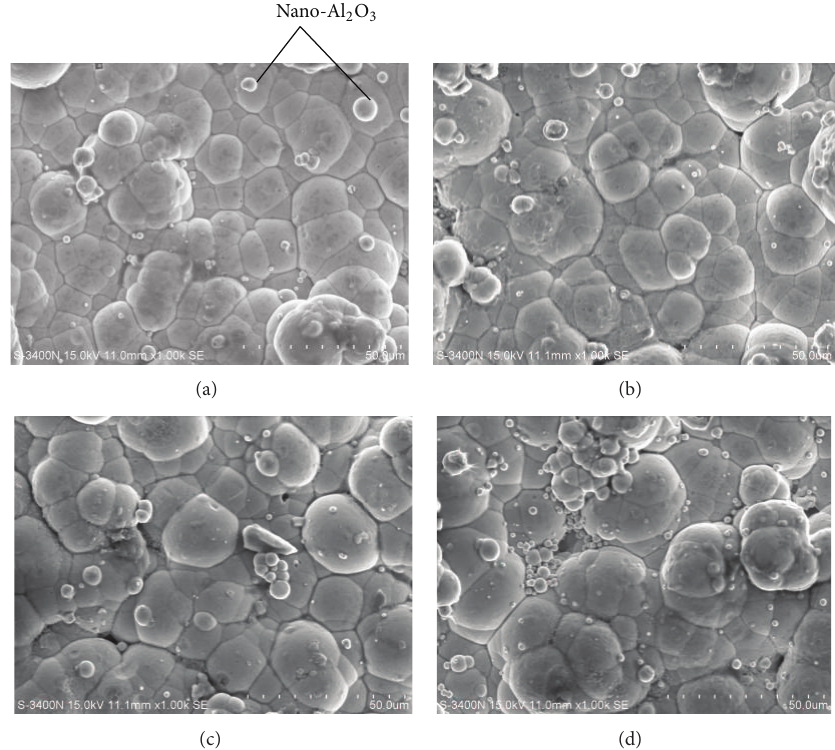
Figure 6: SEM micrograph (1000 × ) of electroless Ni–P coated with SLS surfactant on magnesium (Mg) composite reinforced with multiwall carbon nanotube (MWCNT) at various Al 2 O 3 concentrations: (a) 0.1%, (b) 0.5%, (c) 1%, and (d) 2%.